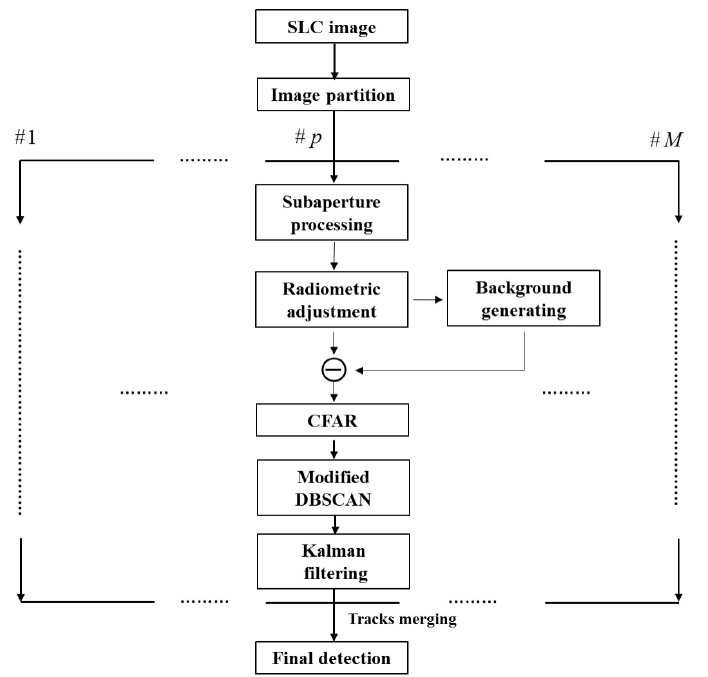
Figure 6. The flow chart of proposed